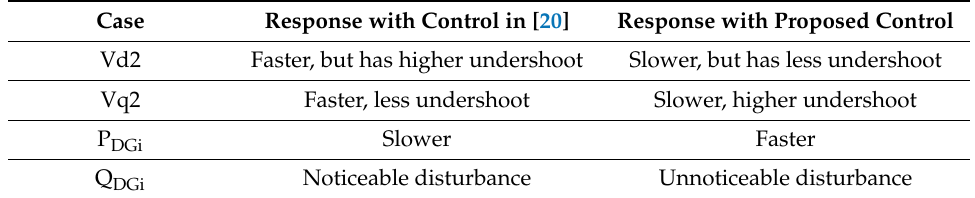
Table 3. Comparison with the control in [20]. Reproduced from [20], the name of the publisher: IEEE Trans. Power